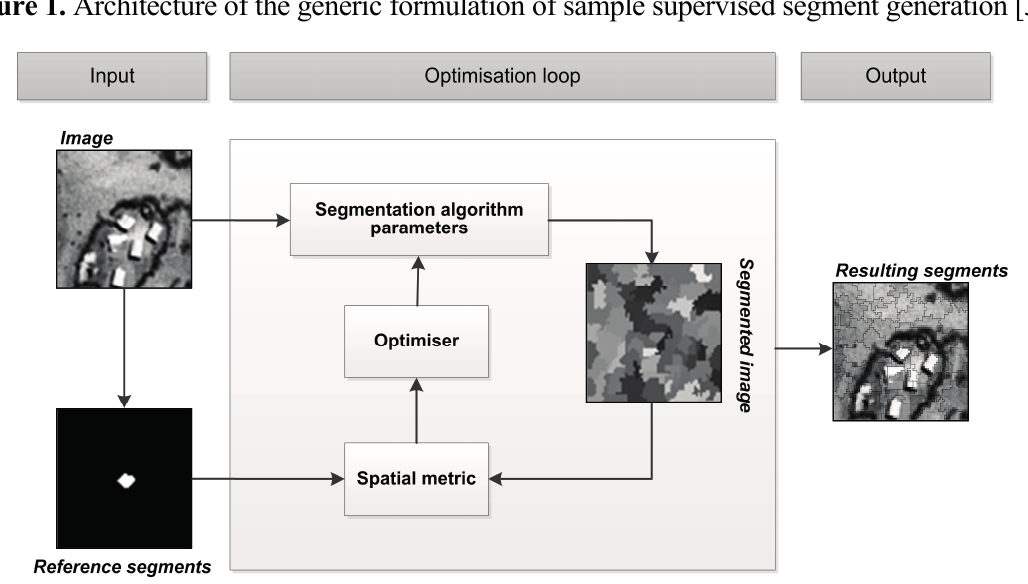
Figure 1. Architecture of the generic formulation of sample supervised segment generation